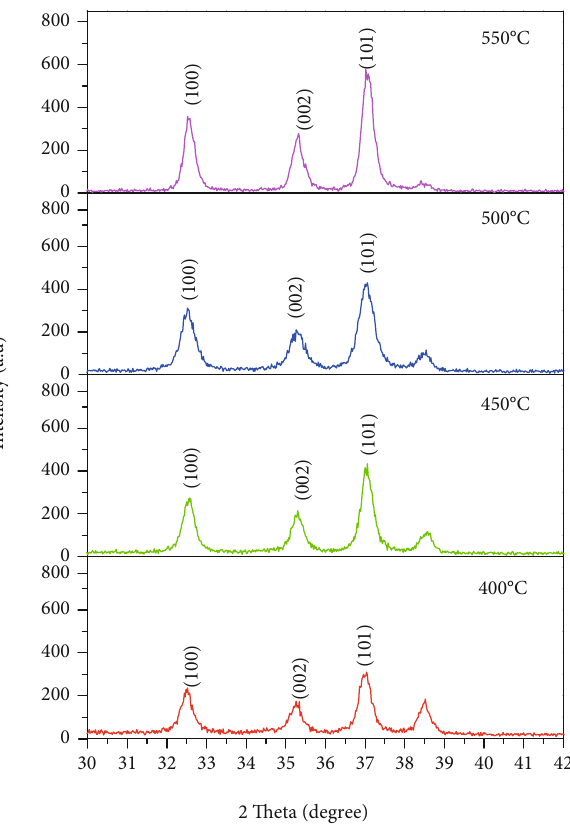
Figure 4: XRD pattern of Mg-doped ZnO thin fi lms at di ff erent annealing